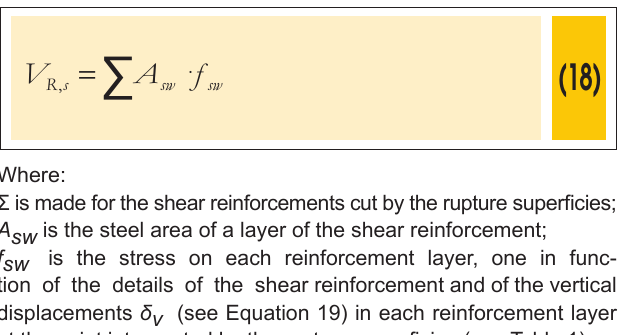
The resistance piece provided by the vertical shear reinforce- ments cut by the rupture superficies can be obtained through Equation 18.